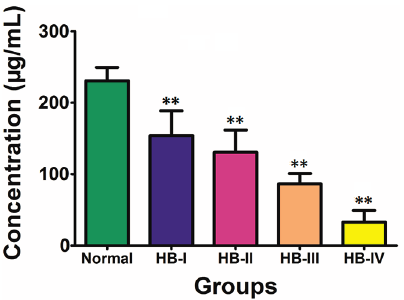
Figure 6. Serum Apo A–I protein levels in the normal healthy children and HB patients.